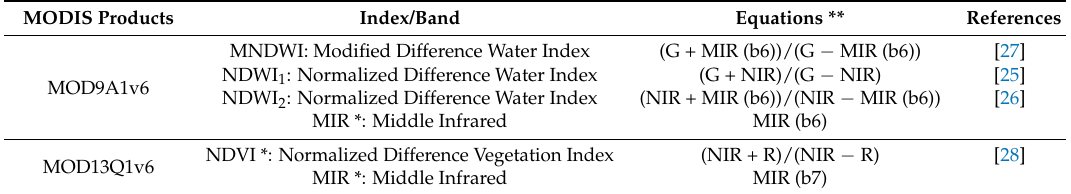
Table 2. Indexes and layers (bands), calculated and/or obtained from Moderate Resolution Imaging Spectroradiometer (MODIS) products, used to calculated lake area